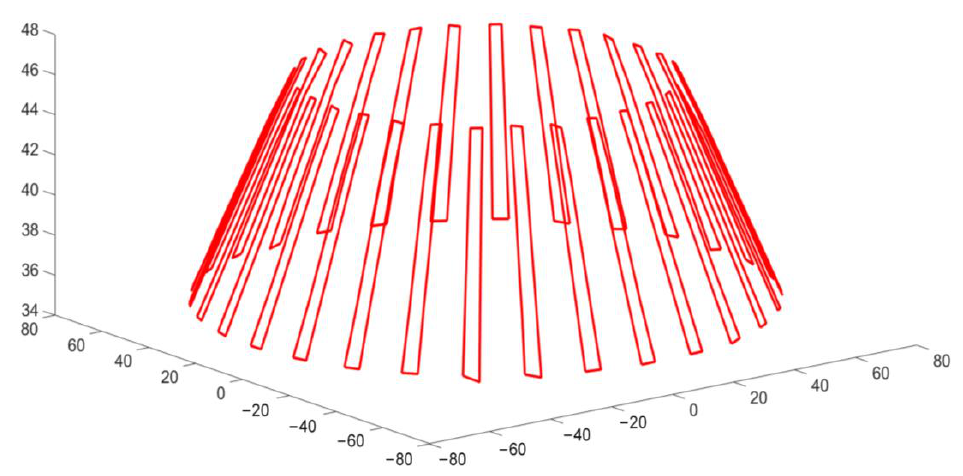
Figure 14. Fitting the tooth surface’s perspective projection.